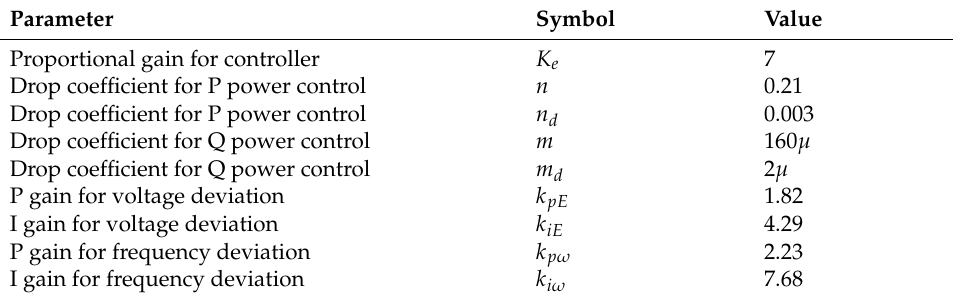
Table 6. Parameters for secondary and tertiary